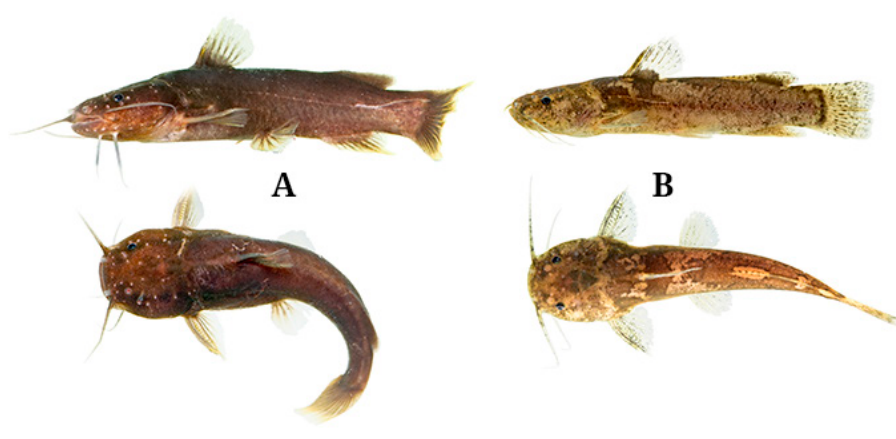
FIGURE 3 | Color pattern in live specimens. A. Microglanis berbixae, MECN-DP-3764, 48.4 mm SL. B. Microglanis variegatus, MZUTI-P-000626, 35.66 mm SL.